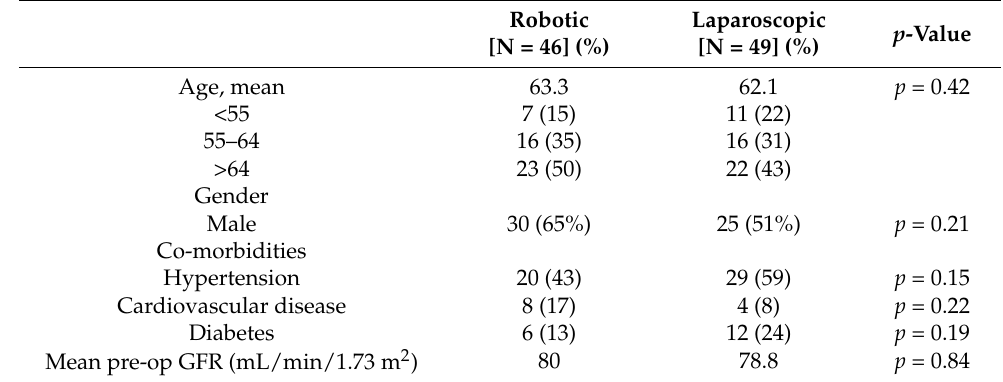
Table 1. Patient demographics, co-morbidities and renal function of those undergoing either laparo- scopic or robotic partial nephrectomy.